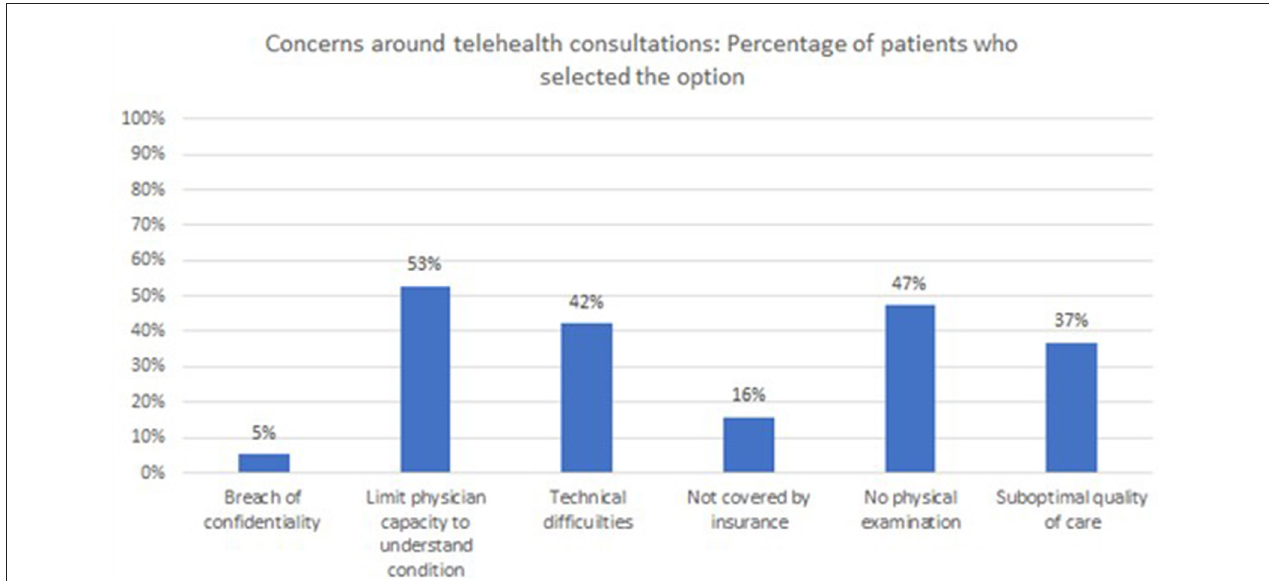
FIGURE 7 | Distribution of patients (who had concerns prior to consultation), based on the selected concern(s).